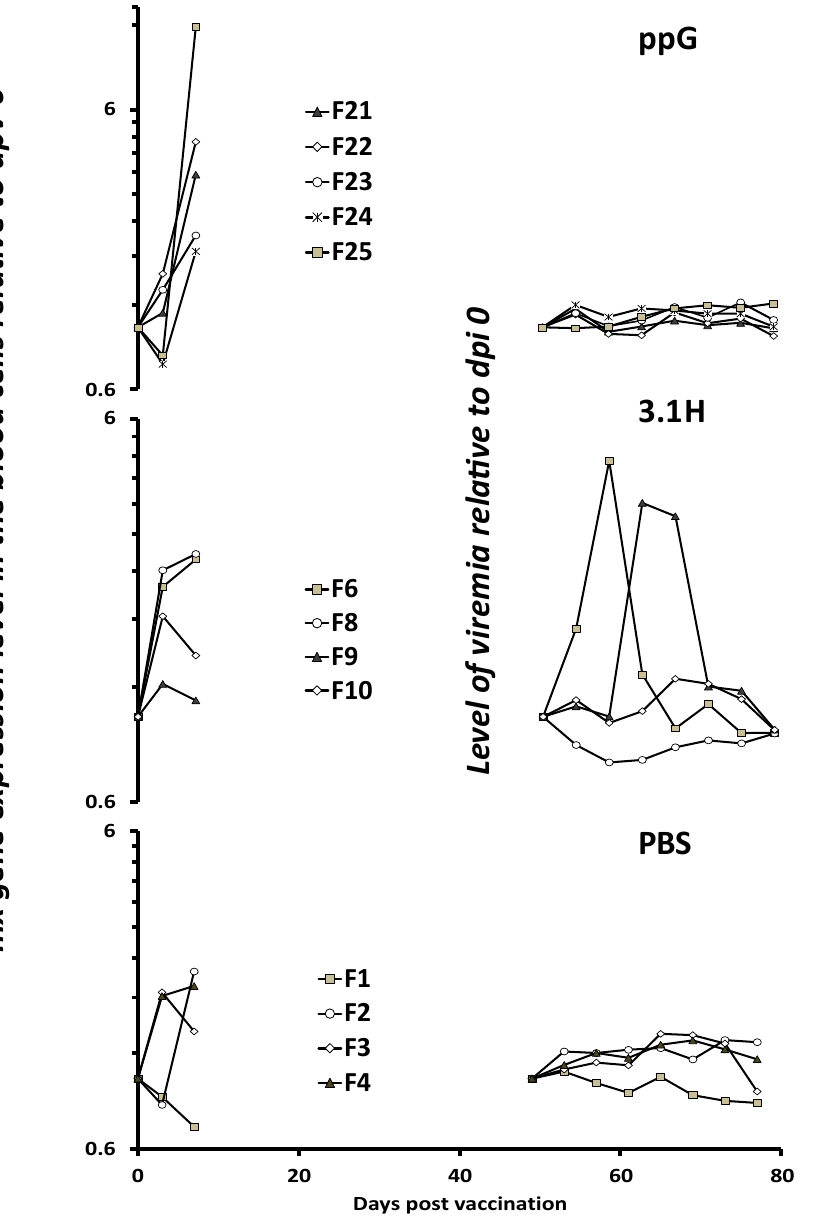
Figure 6. Individual kinetics of mx gene expression in blood cells at 3 and 7 dpv and corresponding viremia at dpv 49–77/ dpi 0–28 (experiment 2) in the PBS-injected-uninfected group (F1, F2, F3, F4; bottom), 3.1H-injected-infected group (F6, F8, F9, F10; middle) and ppG-injected-infected group (F21, F22, F23, F24, F25; top). The pre-infection data are the relative level of mx gene expression in the blood cells expressed as fold change to dpv 0 (pre-vaccination) measured by qPCR (left side, dpv 3 and 7). The post-infection data are the viremia measured in the plasma by the RTG-P1 reporter assay and expressed as fold change to the pre-infected level (dpv 49/dpi 0). The Y-axis scale is loga- rithmic and is identical between the three groups, which have been separated to allow for visuali- sation of individual kinetics. Minor marker labels indicate an increment of 0.6 (0.6, 1.2, 1.8, 2.4, 3.0, 3.6, 4.2, 4.8, 5.4, and 6.0). Within each group, individuals are uniquely identified by a distinctive